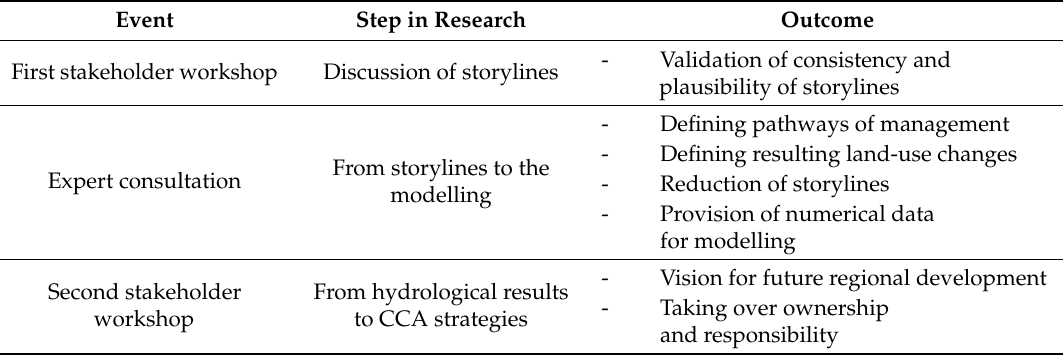
Table 2. Involvement of non-academic stakeholders. CCA—climate change